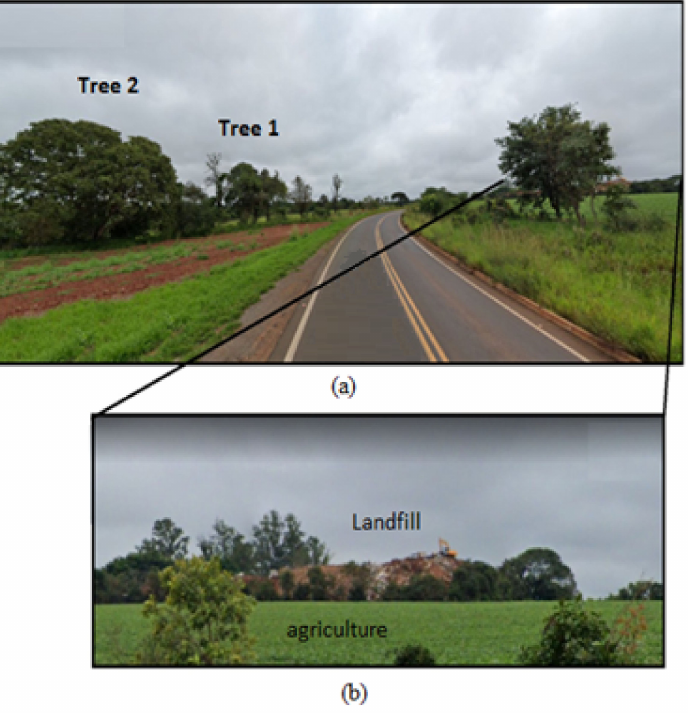
Figure 2. ( a ) Location of trees 1 and 2 near highway edge. ( b ) Landfill near the highway and bean plantation